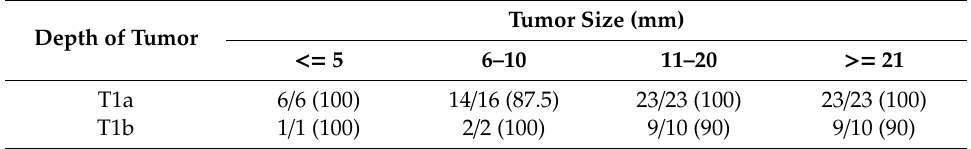
Table 2. Sensitivity based on tumor size and depth (sensitivity,